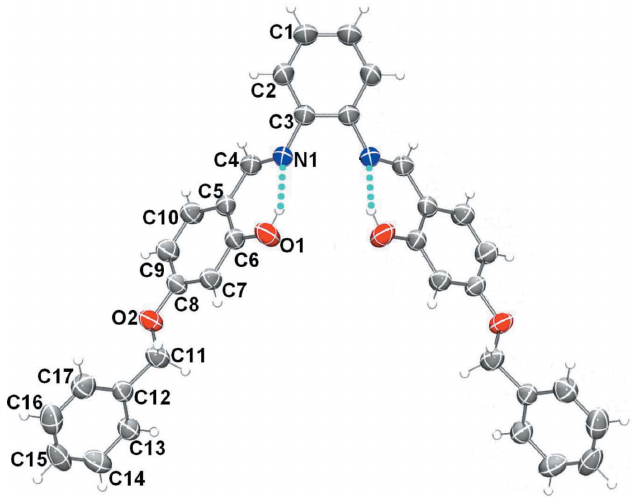
Figure 1 View of the molecular structure of compound (I), with atom labelling. Displacement ellipsoids are drawn at the 50% probability level. Unlabelled atoms are related to labelled atoms by the mirror symmetry code: (i) (cid:4) x , y , z . The intramolecular O—H (cid:2)(cid:2)(cid:2) N hydrogen bonds (see Table 1) are shown as dashed